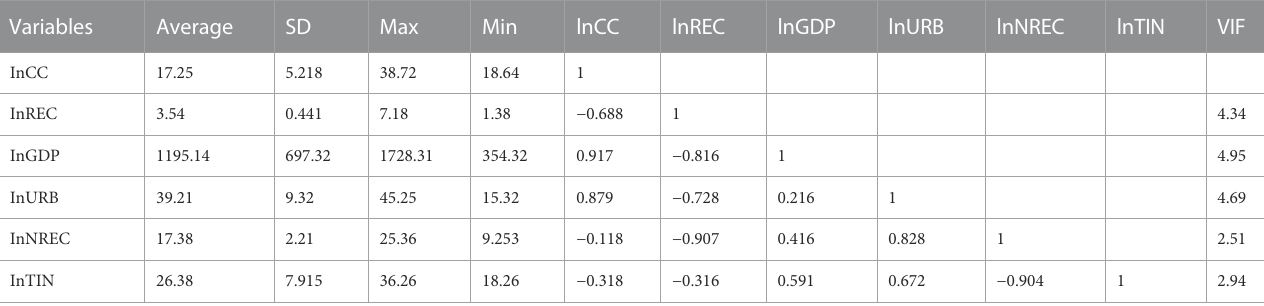
TABLE 4 Panel descriptive statistics and correlation analysis. Variables